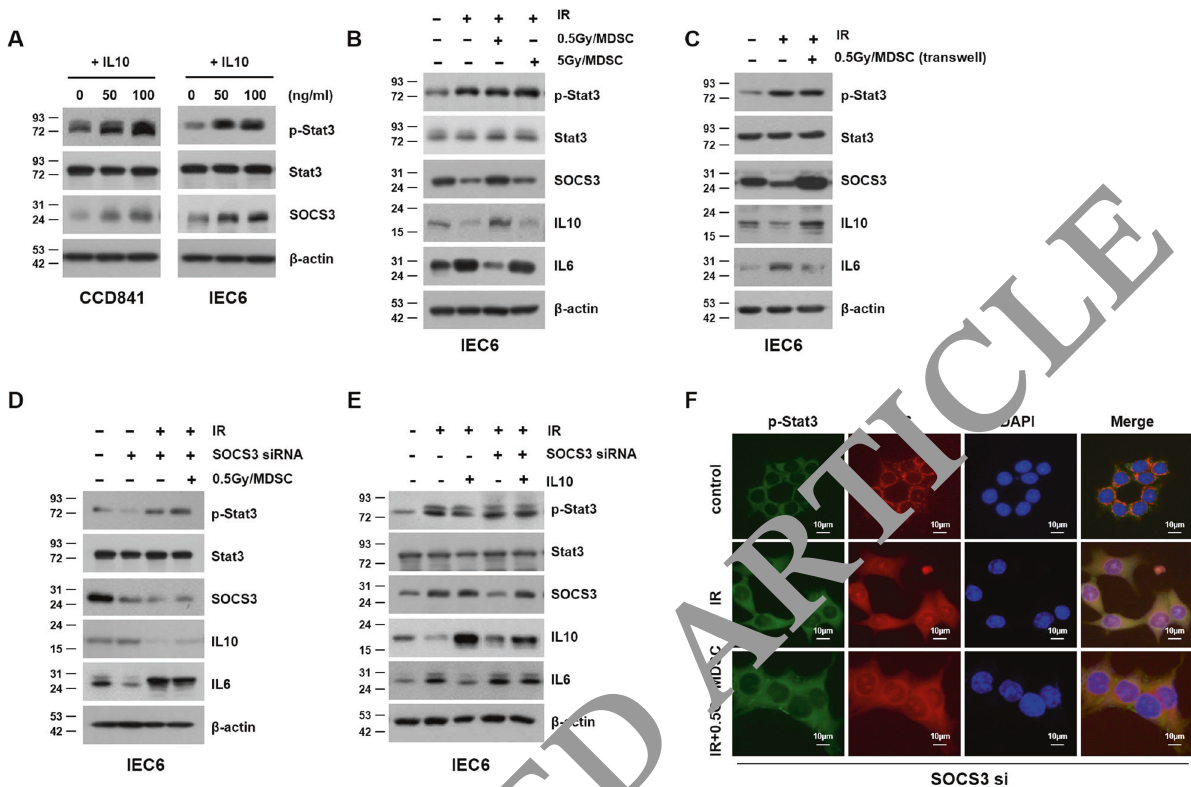
Fig. 6 MDSC-secreted IL10 enhanced STAT3/SOCS3 signaling in vitro. A Western blot analyses were used to determine the expression patterns of IL10-stimulated p-STAT3 and SOCS3 protein levels in CCD841 and IEC-6 cells. B , C Western-blot analysis was used to determine the expression of p-STAT3, STAT3, SOCS3, IL10, and IL6 in co-cultured IEC-6 cells with 0.5 Gy/MDSCs or 5 Gy/MDSCs directly or indirectly using a transwell system. D The expression of p-STAT3, SOCS3, IL10, and IL6 in IEC-6 cells depleted of SOCS3 using siRNA and co-cultured with splenic 0.5 Gy/MDSCs after IR exposure were determined using western blot analysis. E The expression of p-STAT3, SOCS3, IL10, and IL6 in IEC-6 cells depleted of SOCS3 using siRNA and co-cultured with recombinant IL10 after IR exposure were determined using western blot analysis. F Representative immuno fl uorescence images of spleen cells stained for phosphorylated STAT3 (green), IL6 (red), and both p-STAT3 and IL6 (yellow). DAPI staining (blue) was used to determine the number of nuclei. Scale bar = 100 μ m. IR